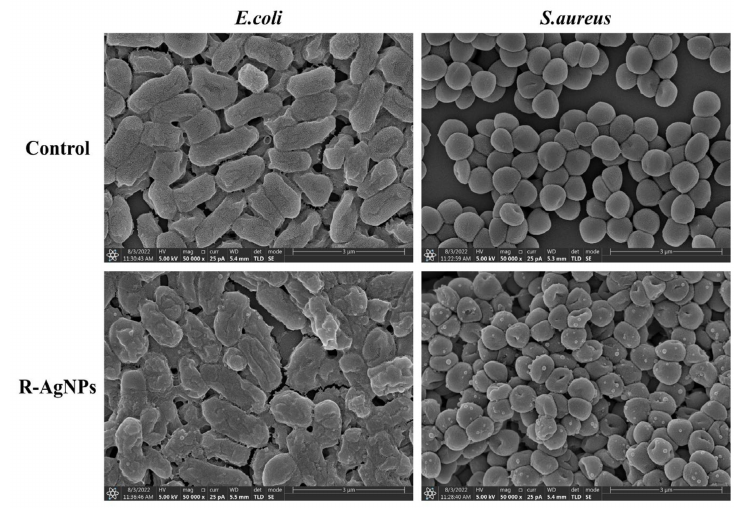
Figure 10. E. coli and S. aureus bacteria in R-AgNPs (2 MIC) detected by scanning electron microscopy. The scale is 3.00 µ